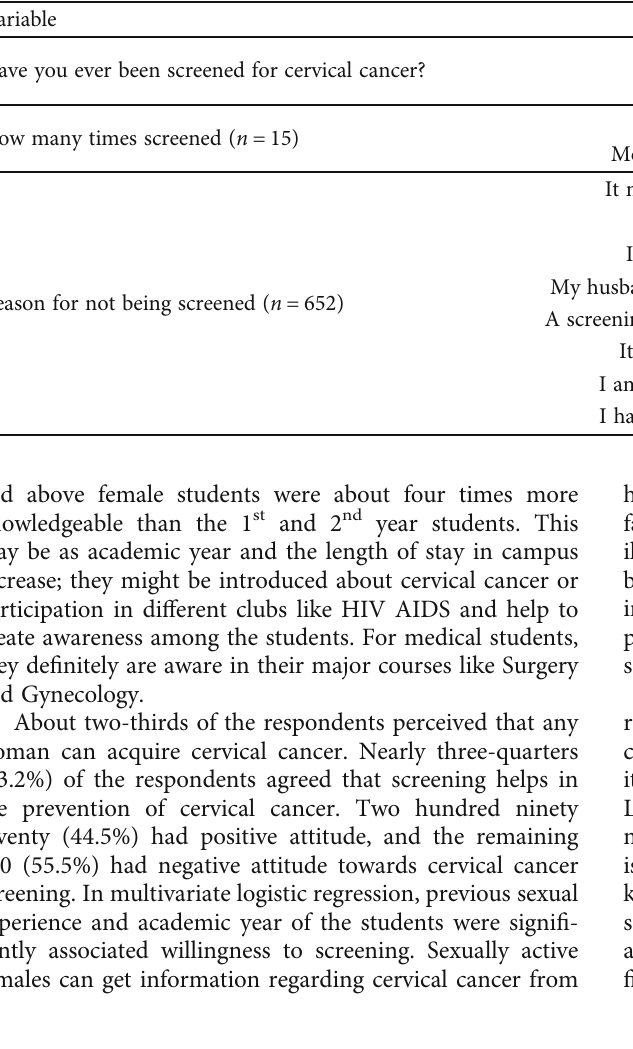
Table 8: Respondents ’ history of screening for cervical cancer at Adama Science and Technology University, Adama, Ethiopia, May 214. Variable Category Frequency Percent Yes 15 2.2% Have you ever been screened for cervical cancer? No 652 97.8% Once 14 2.1% How many times screened ( n = 15 ) More than once 0.1%